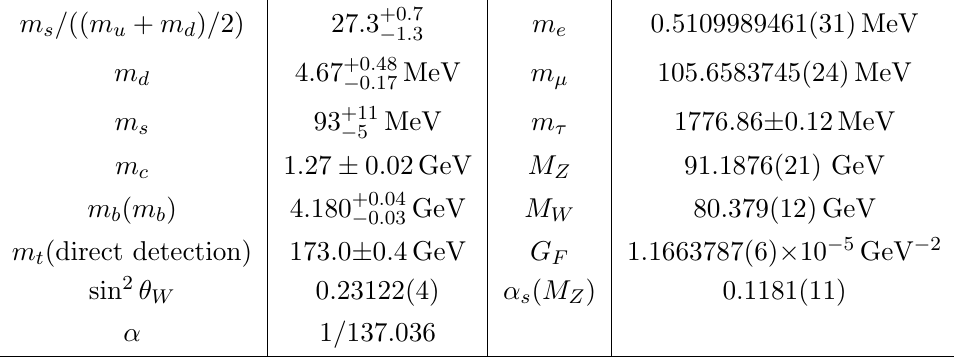
Table 1 . The input parameters in our analysis. All values come from ref.